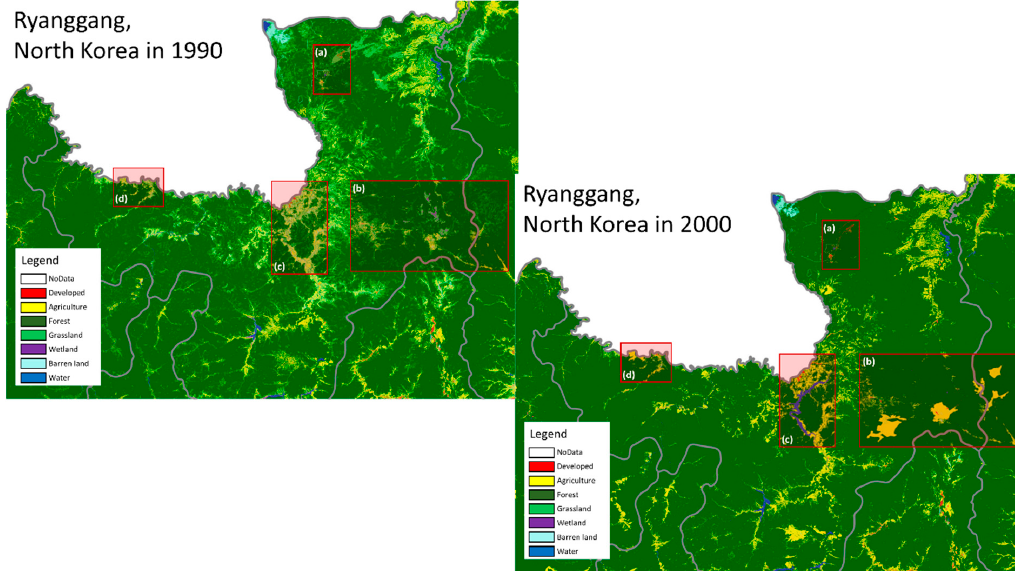
Figure 5. The example of land use and cover changes in Ryanggang between 1990 (upper) and 2000 (lower) with the currently available data set produced by the Ministry of Environment (MoE) using Landsat TM imagery (1991–1999) and Landsat 7 ETM + imagery (2008–2010) (image sources: [78] and revised by